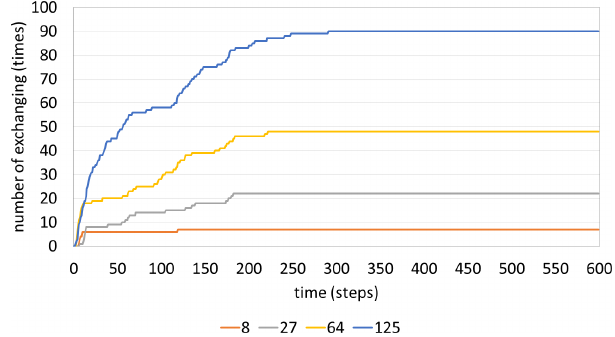
Fig. 21. Number of exchanging AAs in the formations with di®erent numbers of